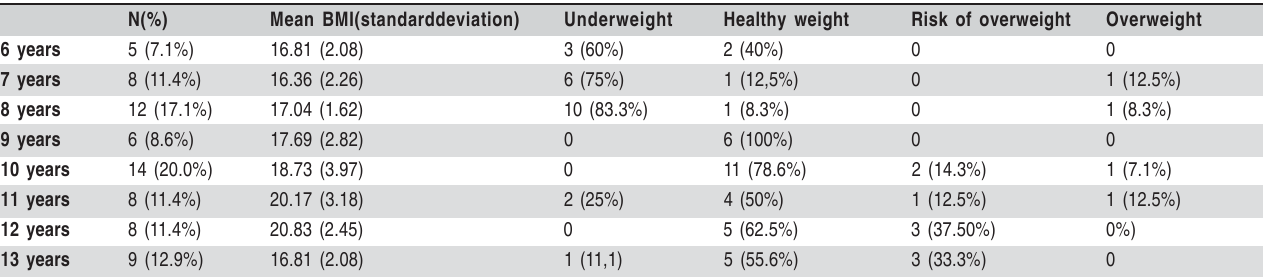
Table 1. Mean BMI and weight classification according